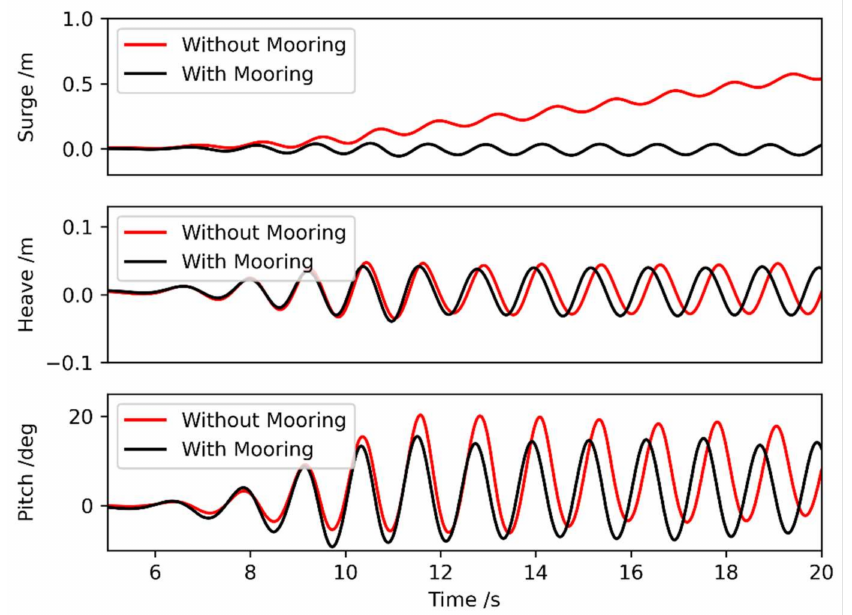
Figure 9. Comparison of the 3-DoF motions for wave #1 with and without mooring.